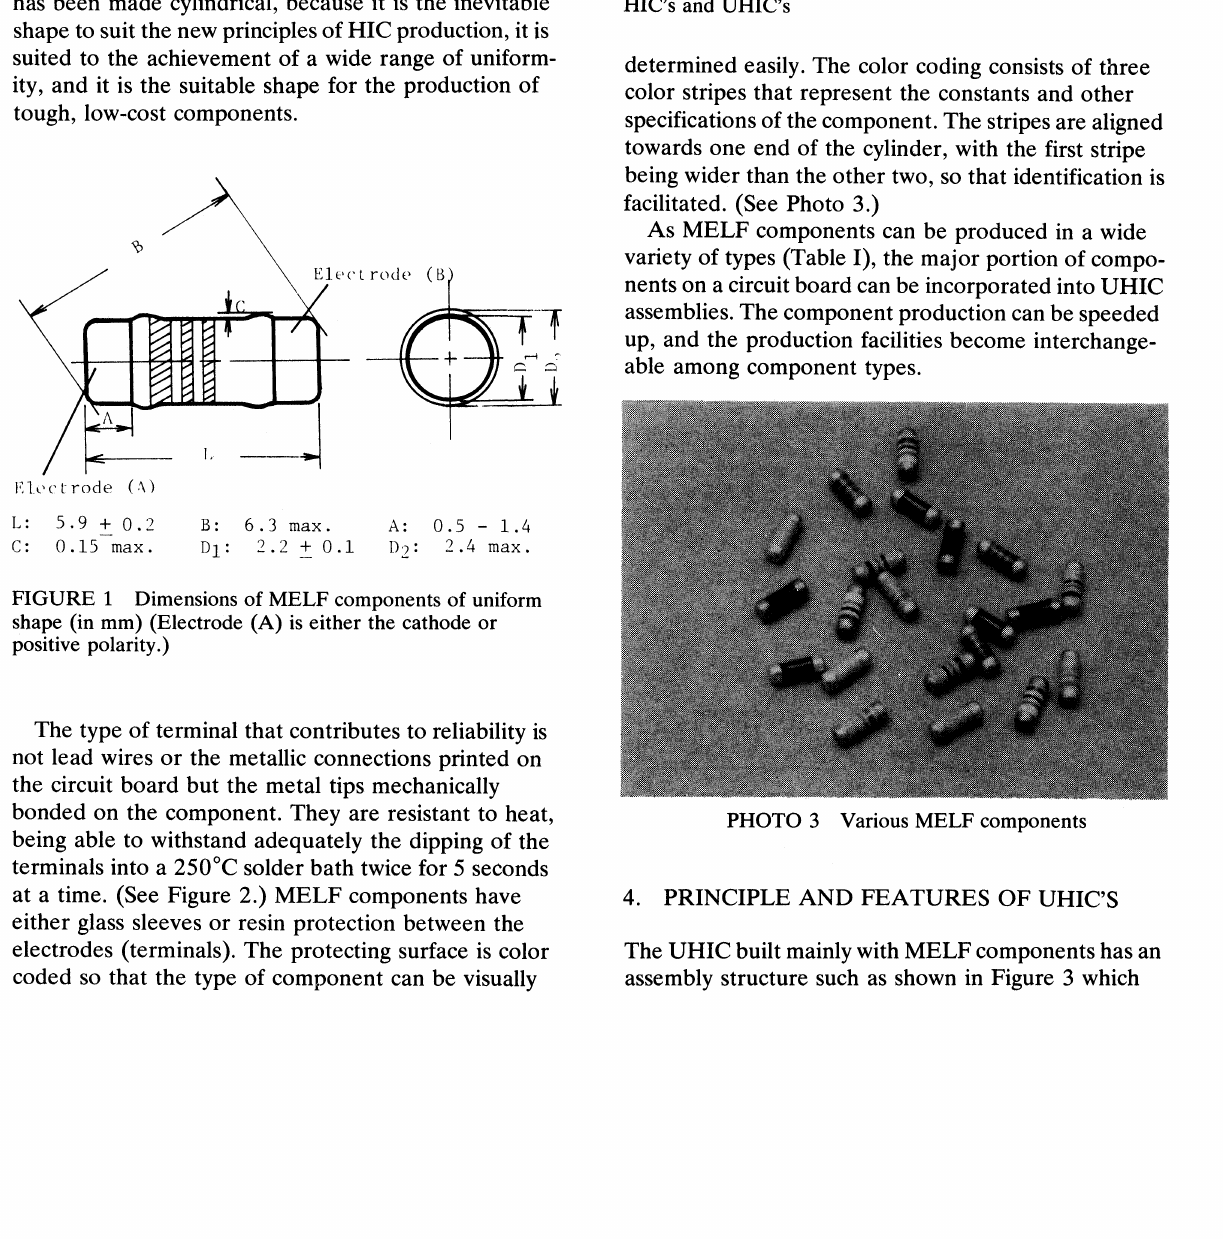
FIGURE 2 Comparison of soldering conditions for ordinary HIC’s and UHIC’s determined easily. The color coding consists of three color stripes that represent the constants and other specifications of the component. The stripes are